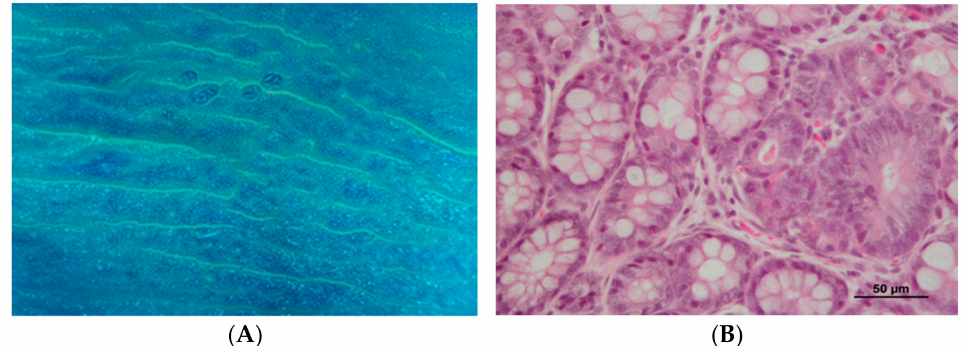
Figure 3. Colon analysis. ( A ) Presence of aberrant crypt foci (ACF) in the colon of CRC2 group (methylene blue staining, stereomicroscope); ( B ) Colon with the presence of focal mild epithelial dysplasia, CRC1 group (HE